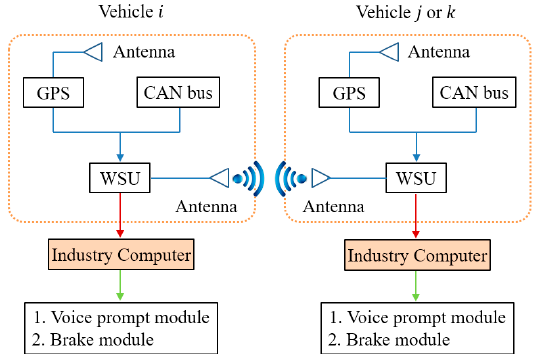
Figure 6. The overall architecture of the V2V communication system. The onboard equipment includes onboard GPS, CAN bus, and onboard WSU. All the driving information of the vehicle is collected to the vehicle WSU by cable, and experiment vehicles can share information through WSU by wireless transmission .